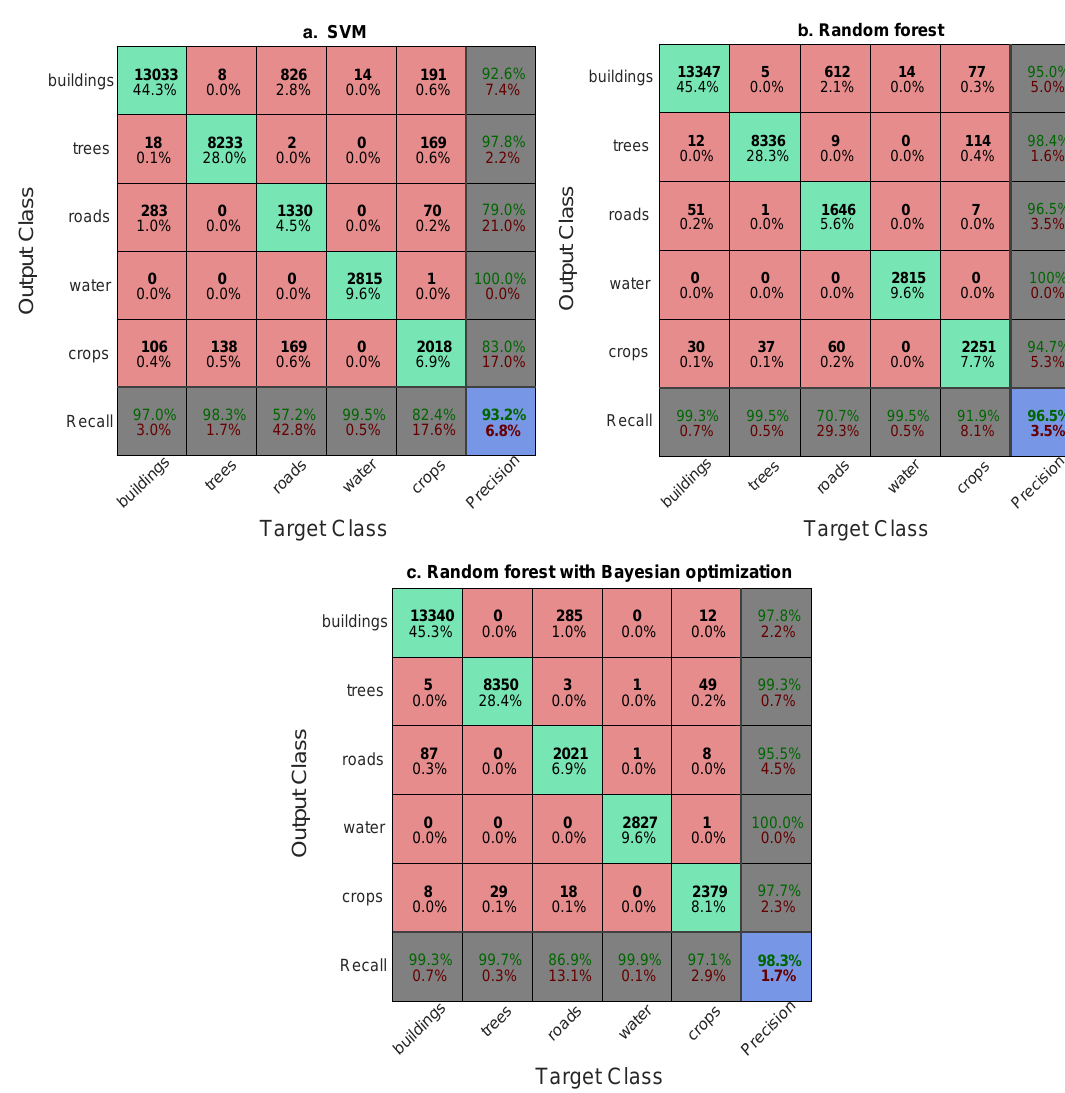
Figure 9. Confusion matrix of the classifiers ( a ) SVM, ( b ) Random forest, ( c ) Random forest with Bayesian optimization) with full multispectral band